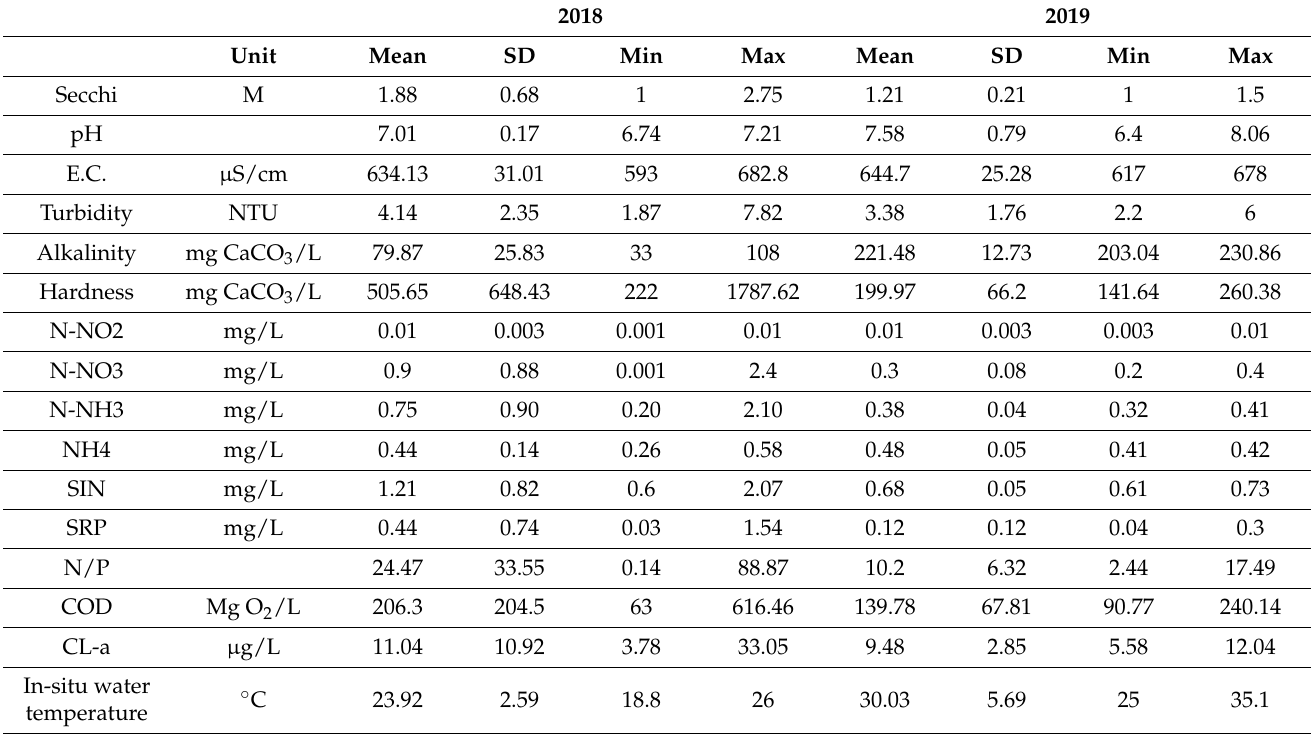
Table 1. Physical and chemical parameters of the samplings per